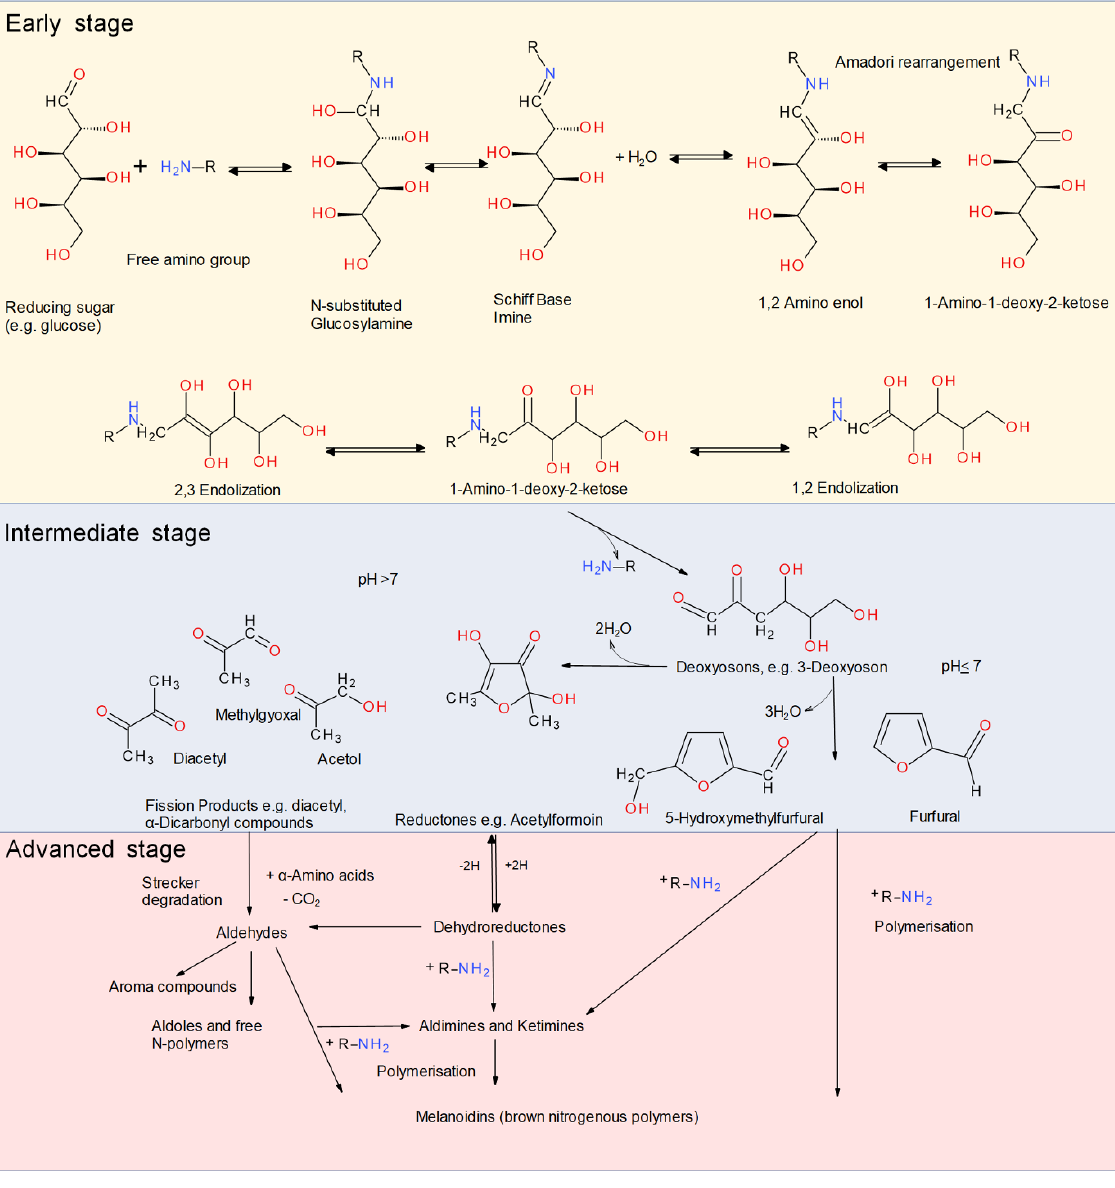
Figure 1. Schematic representation of the three stages of the Maillard reaction modified from Hodge [51] and Martins et al. [52] .